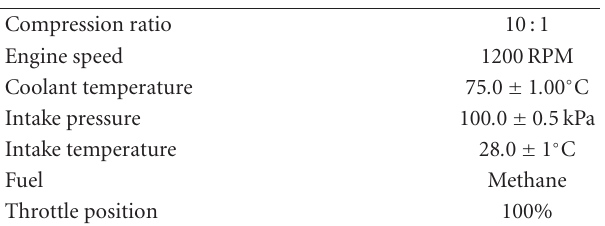
Table 2: Engine operating